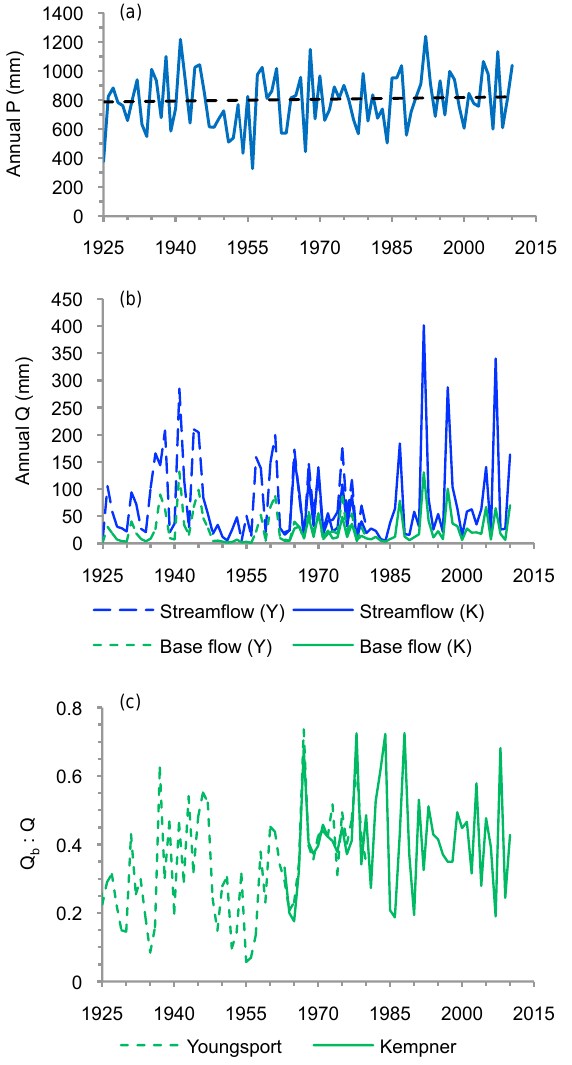
Figure 5. Precipitation and streamflow trends of the Lam- pasas River basin. (a) Precipitation showed no directional trend. (b) Streamflow showed no directional trend at either the Youngsport (Y) or Kempner (K) station, despite being highly variable. (c) Base flow as a proportion of total streamflow displayed an upward trend over the first portion of the study